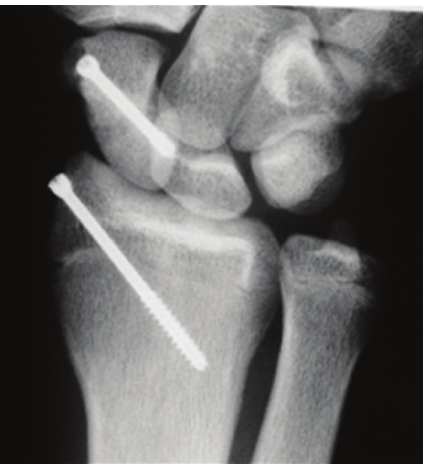
Figure 3: Plain PA radiograph shows the percutaneous fixation and radial styloid process in situ fixation 8 weeks after